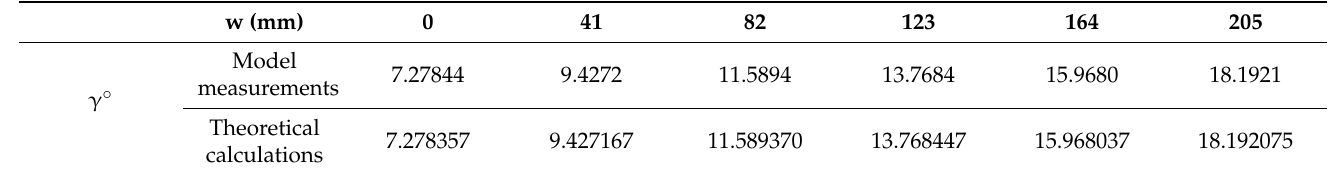
Table 1. Measured and calculated values of the installation angle ( γ ) of the working faceplate in the 3D model.